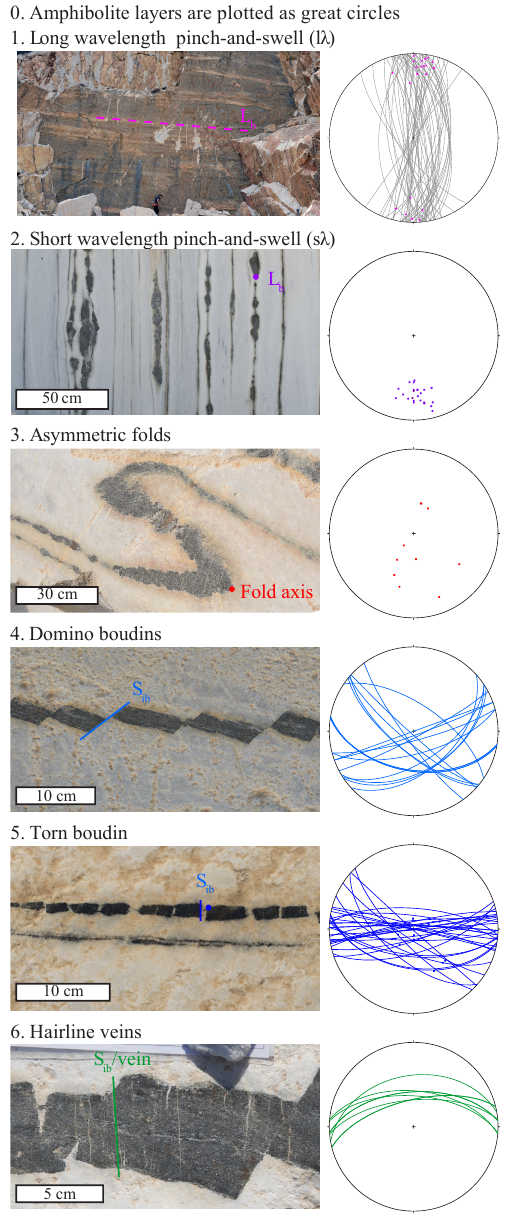
Figure 4. Overview of the structures found in the study area and their orientation plotted in stereonets (lower hemisphere). Images on the left show typical examples of the structures in the field. Indi- cators highlight the component of the structure that is shown in the stereonet: amphibolite layers are plotted as great circles (1). Pinch- and swell boudins (1, 2) do not have boudin faces, therefore the long axis of the boudin ( L b ) is plotted. Folds are represented by their fold axis (3). The plane of the boudin face S b is plotted for domino boudins (4) and torn boudins (5) and hairline veins (6) are shown as great